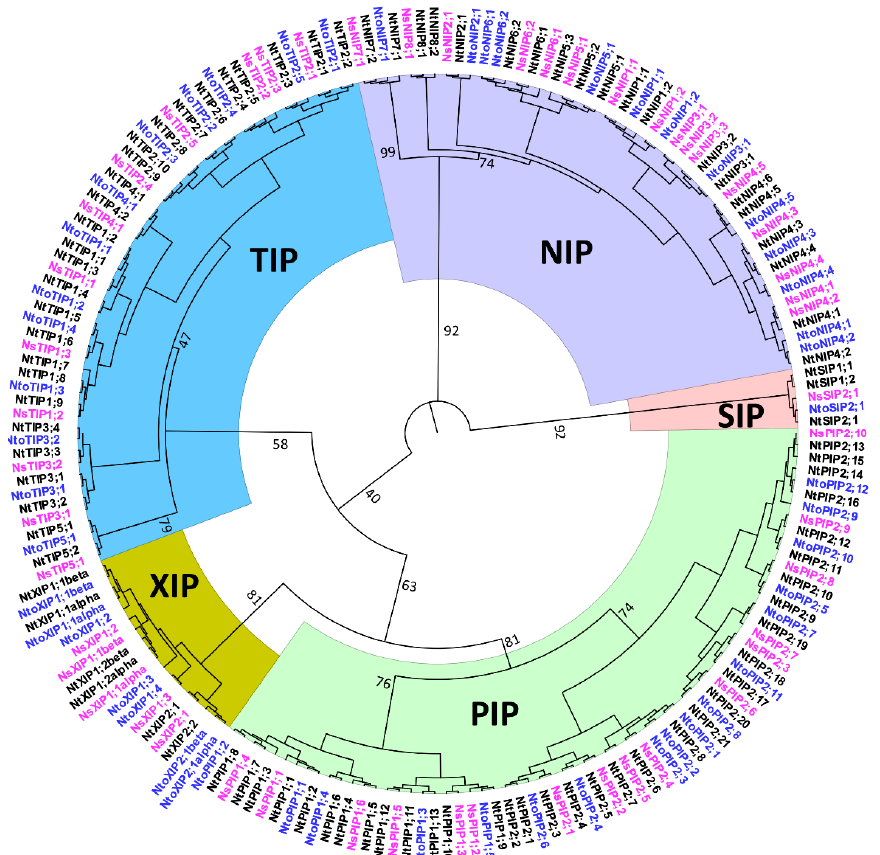
Figure 2. Phylogenetic relationships among N. tabacum (Nt) AQPs and its two ancestors, N. sylvestris (Ns) and N. tomentosiformis (Nto) AQPs. The deduced amino acid sequences of NtAQPs, NtoAQPs, and NsAQPs were aligned using the Clustal Omega server (http://www.ebi.ac.uk/Tools/msa/ClustalOmega/) and a phylogenetic tree was constructed using Maximum Likelihood method based on the JTT matrix-based model with 1000 bootstraps. The NtAQPs clustered into five different subfamilies (PIPs, TIPs, NIPs, SIPs and XIPs), with the corresponding NtoAQP and NsAQP subfamilies. Each AQP subfamily is shown with a specific background color. NtAQPs are indicated in black, NtoAQPs are in blue, and NsAQPs are in magenta.